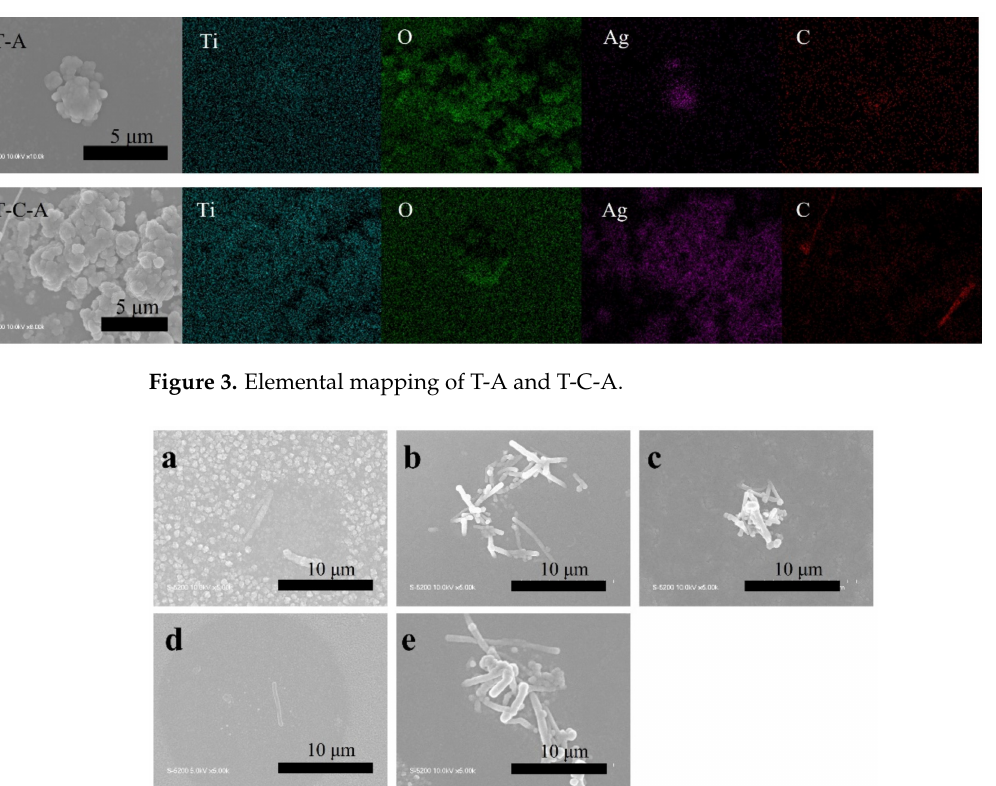
Figure 4. SEM images of T-C-A films deposited using different concentrations of CNT/Ag mixed suspensions: ( a ) T-C-A0 (0.25 wt%/0.1 wt%), ( b ) T-C-A1 (0.25 wt%/0.05 wt%), ( c ) T-C-A2 (0.25 wt%/0.01 wt%), ( d ) T-C-A3 (0.01 wt%/0.1 wt%), and ( e ) T-C-A4 (0.5 wt%/0.1 wt%).